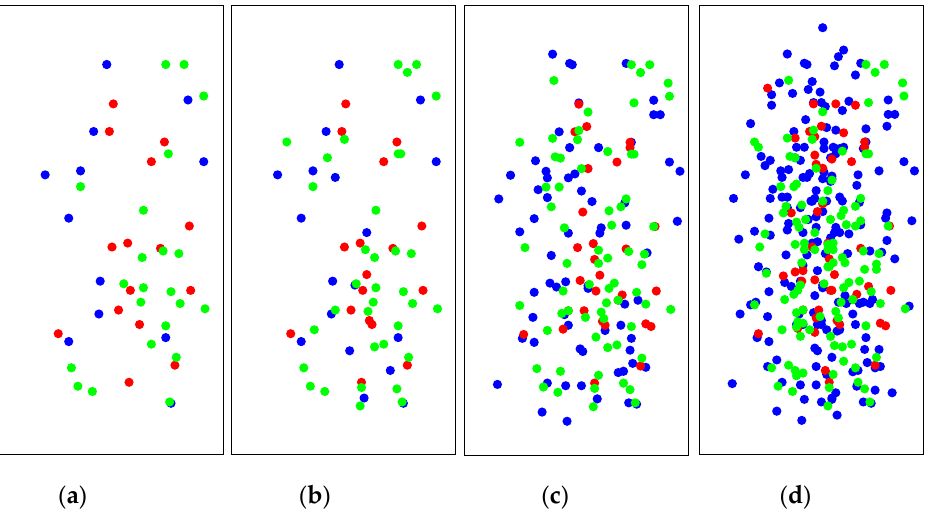
Figure 16. AE spatial location and crack source identification of sample S-T1-20. A blue AE denotes a tensile crack, a red AE denotes a mixed type, and a green AE denotes a shear crack. ( a ) The results when σ cc was reached; ( b ) the results when σ ci was reached; ( c ) the results when σ cd was reached; ( d ) the results when σ p was reached. From Figures 15 and 16, the tensile, shear and mixed AE percentages of sandstone samples at different crack propagation can be obtained, as shown in Tables 4 and 5. Table 4. Different crack types in the process of rock failure of sample S-T1-0.